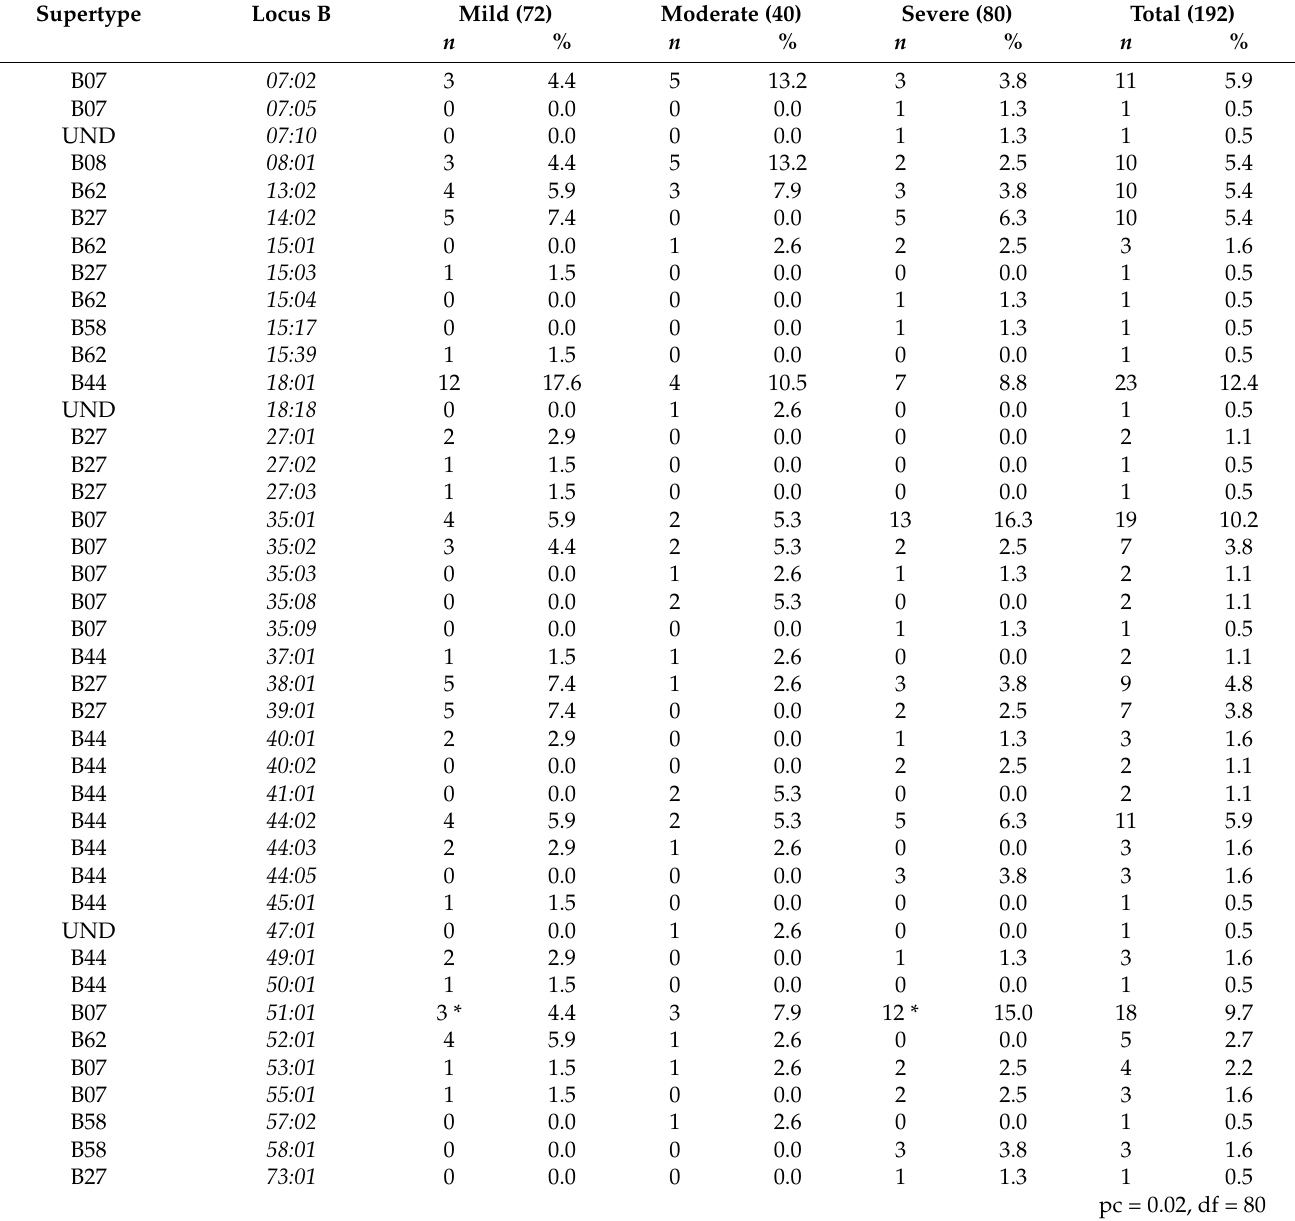
Table 2. Frequencies of HLA-B alleles and HLA-B supertypes in 96 Italian patients clustered on the basis of COVID-19 severity classification in line with Chen and colleagues